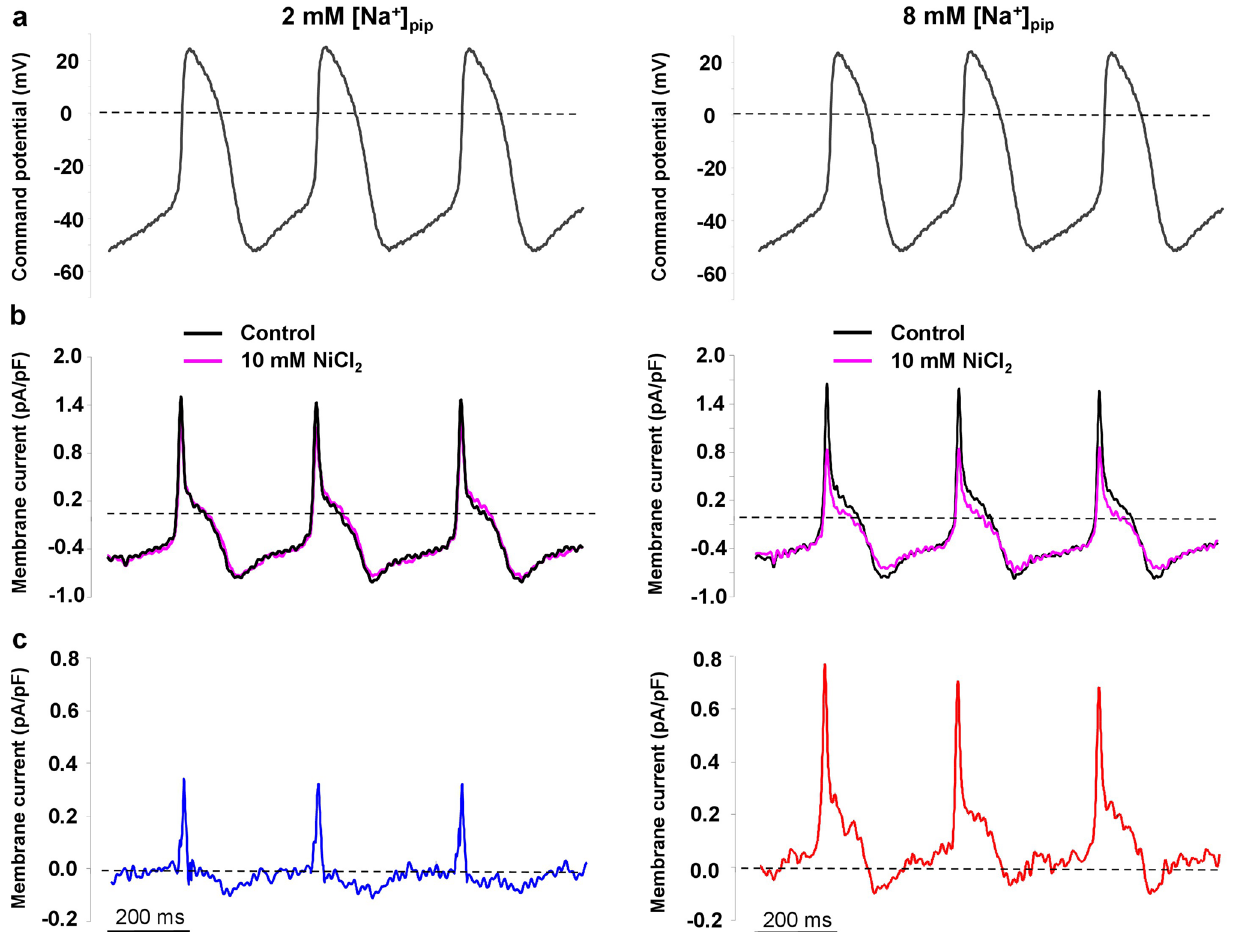
Figure 2. Characterization of the NCX current as a Ni 2+ -sensitive current under a canonical SN action potential (panel a ). The intracellular Ca 2+ was buffered with 10 mM EGTA, K + and Ca 2+ currents were inhibited. Left side of the Figure demonstrates 2 mM [Na] pip , right side shows 8 mM [Na] pip. Panel ( b ) illustrates the control (black) and the NiCl 2 -treated currents (pink) and panel ( c ) depicts the subtracted